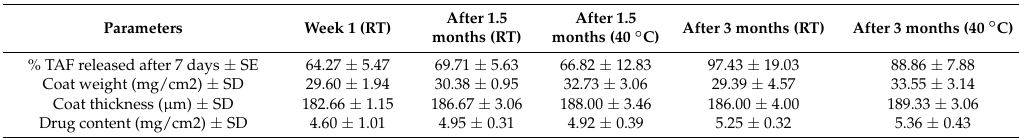
Figure 10. In vitro release profiles of TAF from the optimized suspension patch. Table 7. Characterization parameters of optimized patch “SP7” up to three months at ambient and accelerated storage